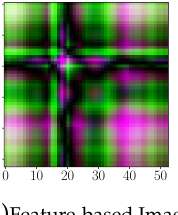
of the forward-direction signal.